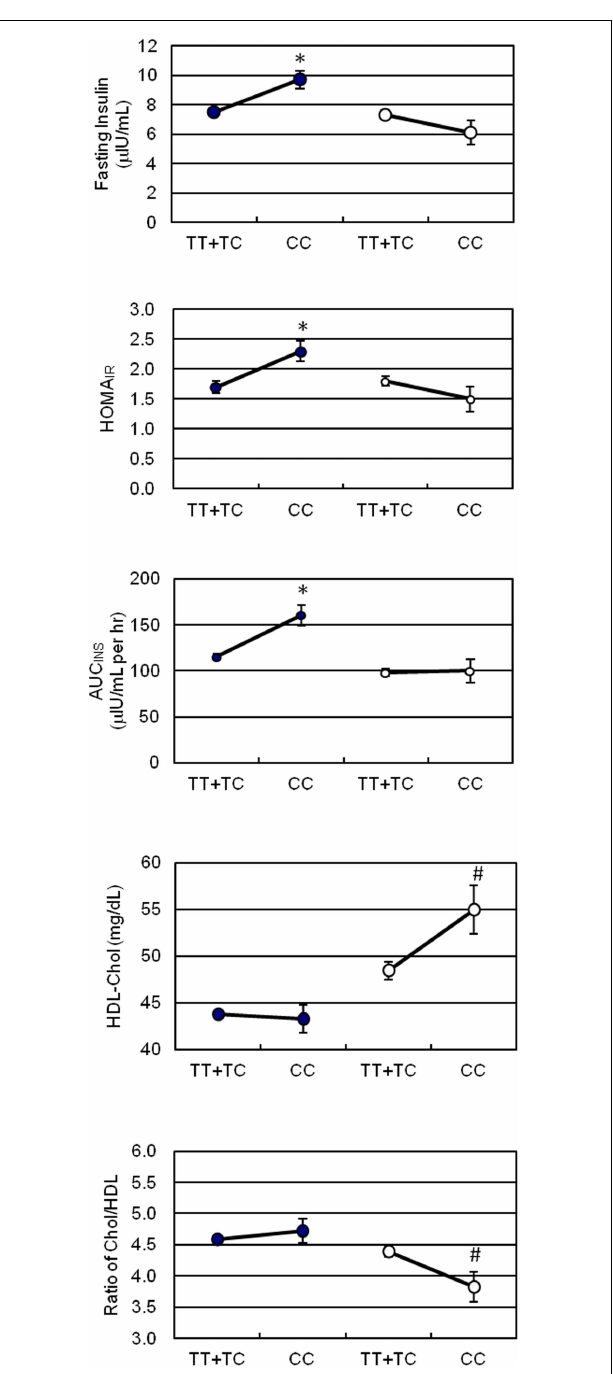
FIGURE 1 | Effect of the ET A receptor genotypes on surrogate indices of insulin sensitivity, HDL-cholesterol, and atherogenic index . - • - for Chinese, - ◦ - for Japanese.Vertical lines represent SD. Significant differences denote as * p < 0.01, # p < 0.05.